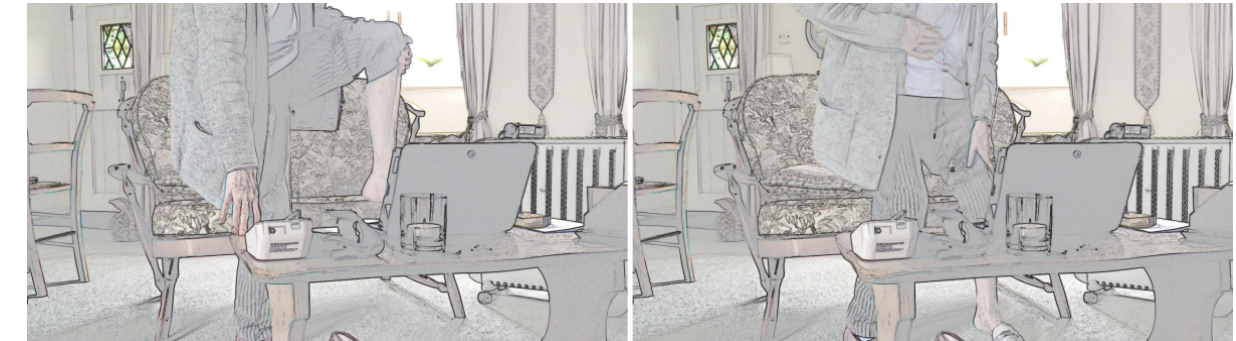
Figure 1. Patient attempting video examination whilst